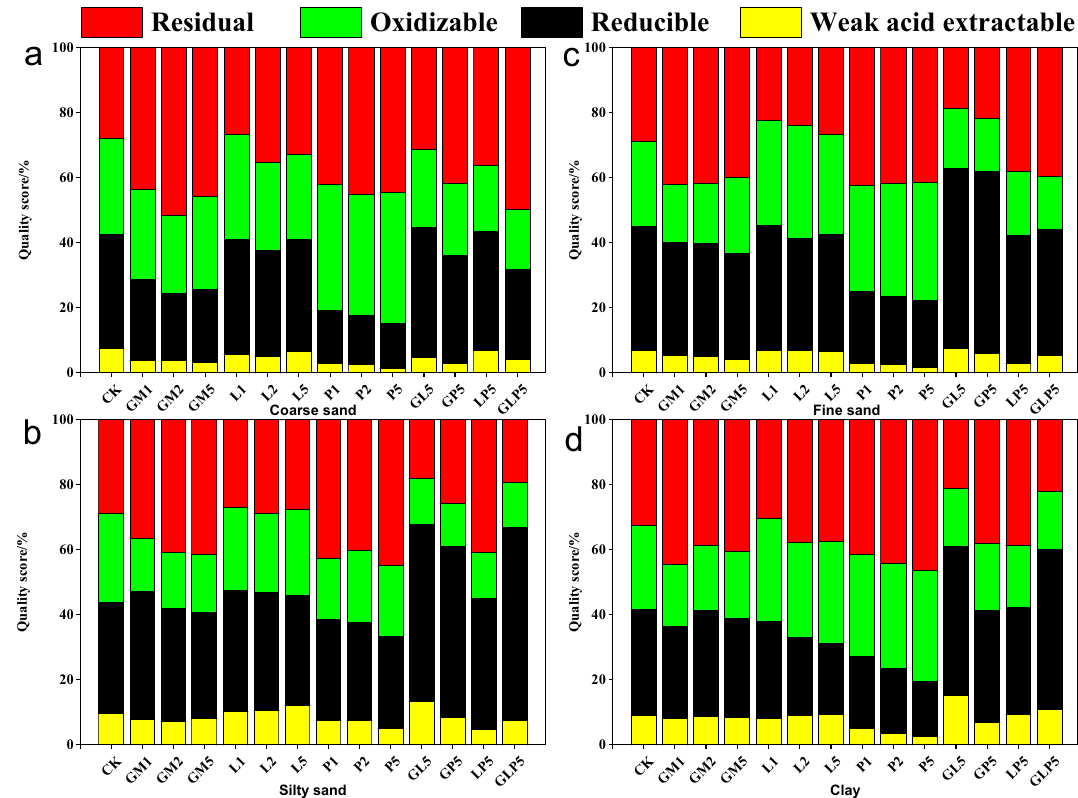
Figure 6. Effect of passivators on fractions of Pb in soil with different particle sizes (Origin 2019b). (CK: control check, GM: goat manure, L: Ca(OH) 2 , P: Ca(H 2 PO 4 )·2H 2 O, GL: goat manure + Ca(OH) 2 , GP: